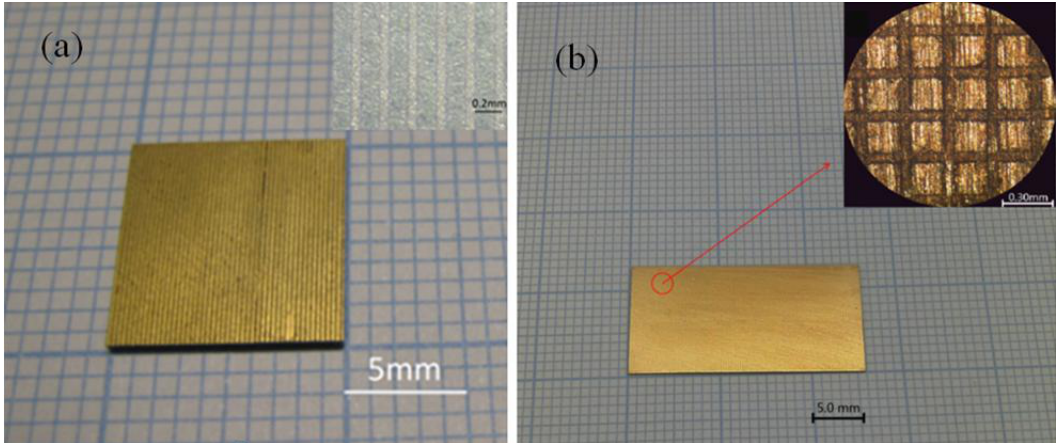
Figure 15. ( a ) Photograph of the PIN-PMN-PT/epoxy 2-2 composite and enlarged image of a randomly selected area on the composite (inset); ( b ) Photograph of the PIN-PMN-PT/epoxy 1-3 composite and enlarged image of a randomly selected area on the composite (inset) (with permission from [80,81]).